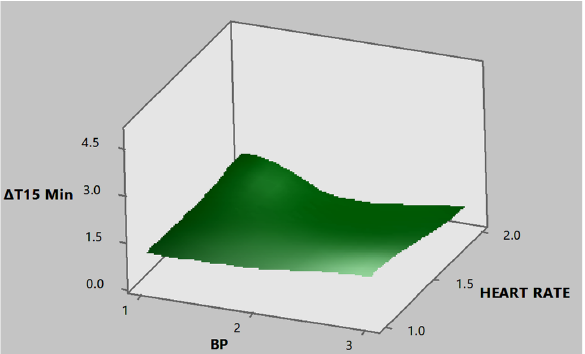
Figure 12. Response surface produced for the tolex area from the palm of the hand for the mini- mum temperature difference in time 15 ′ and the BP and heart rate factors. Table 5. Diagnostic results of asymmetric wrist injuries in the palmar region of the hand.